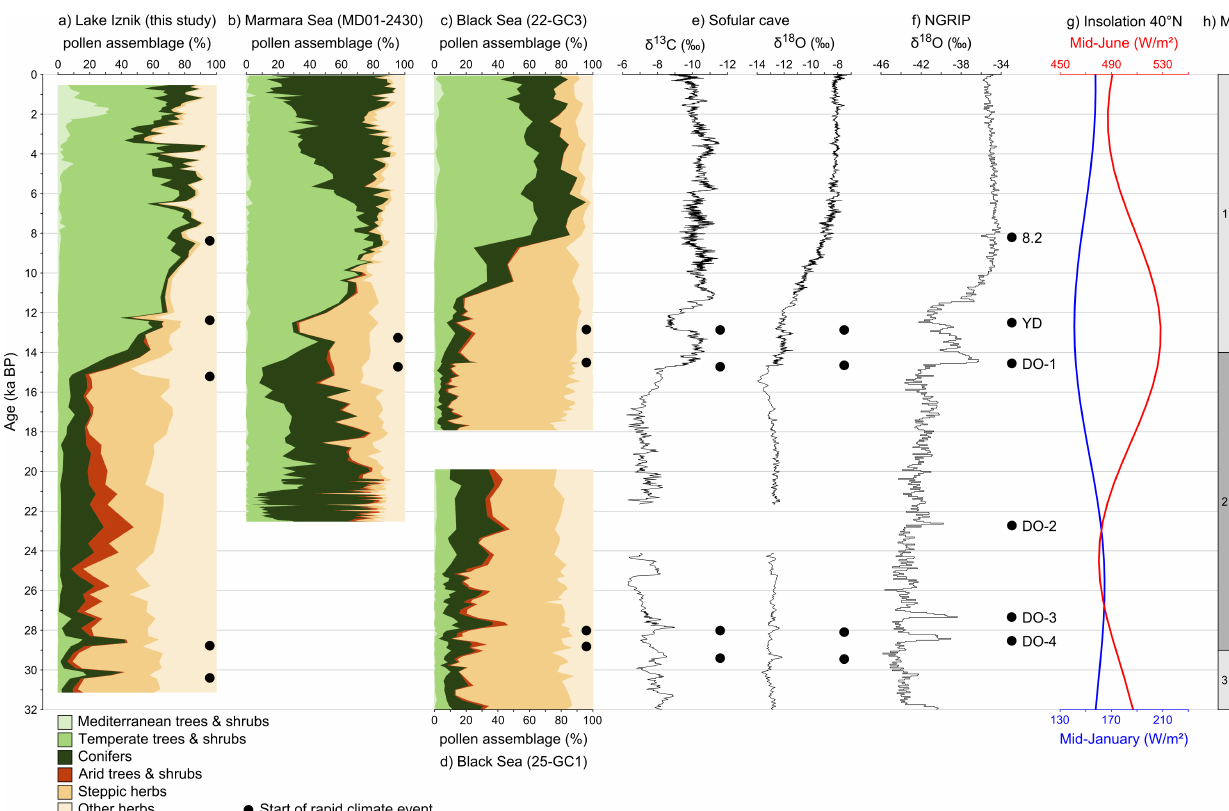
Figure 6. Comparison of pollen assemblages from (a) Lake Iznik (this study), (b) Marmara Sea, core MD01-2430 (Valsecchi et al., 2012), (c) Black Sea, core 22-GC3 (Shumilovskikh et al., 2012), and (d) Black Sea, core 25-GC1 (Shumilovskikh et al., 2014) with (e) isotope data from Sofular cave (Fleitmann et al., 2009), (f) isotope data from Greenland (NGRIP members, 2004), (g) mid-June and mid-January insolation (Berger, 1978; Berger et al., 2007), and (h) marine isotope stages (MIS; Lisiecki and Raymo, 2005). Dots mark Dansgaard- Oeschger events (DO), the Younger Dryas (YD), and the 8.2